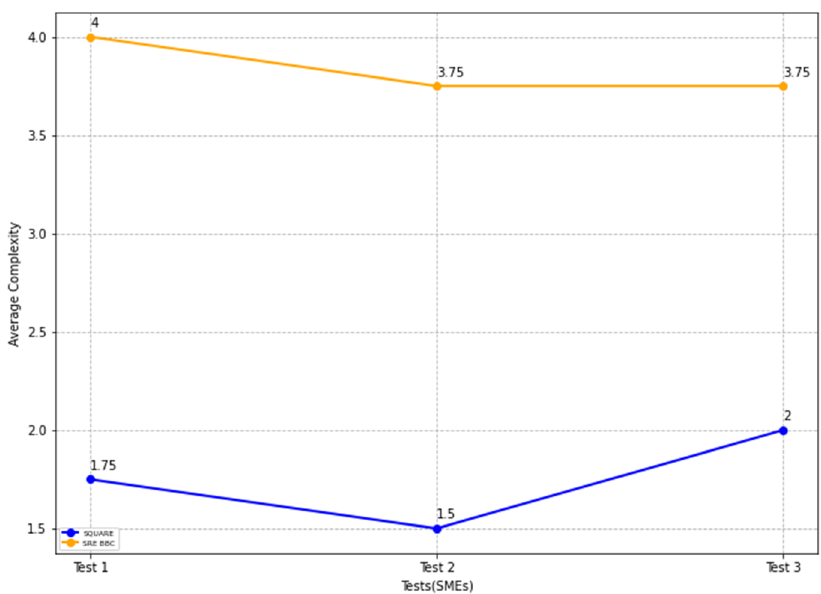
Figure 22. The comparison of quantified average complexity level score for SQUARE and SRE_BBC (Replicated Study).